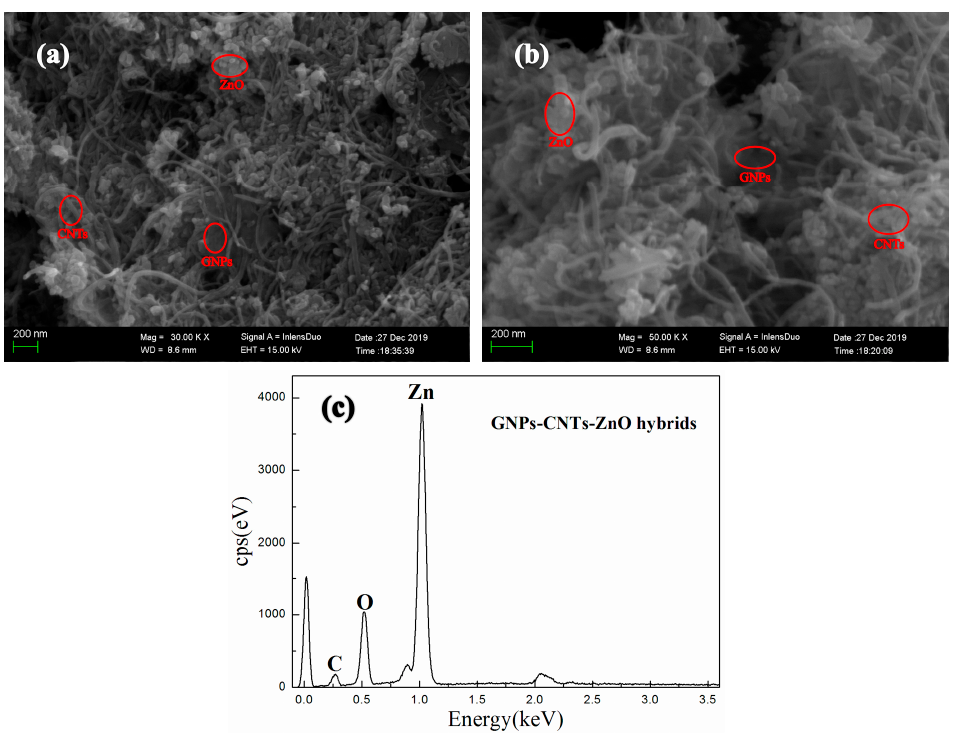
Figure 2. SEM images ( a , b ) and EDS ( c ) of graphene nanoplatelets (GNPs)-CNTs-ZnO hybrids.